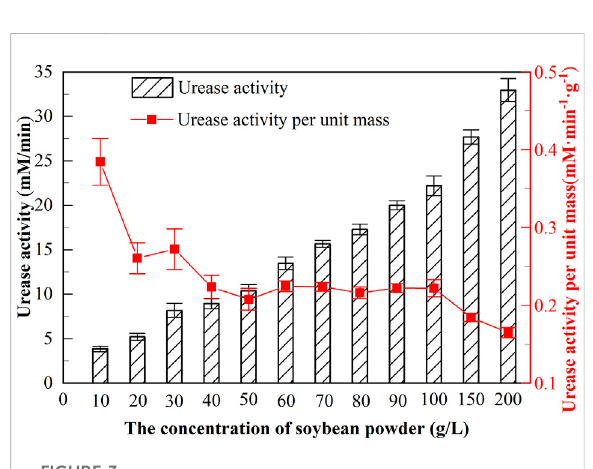
FIGURE 3 Effect of soybean powder concentration on urease